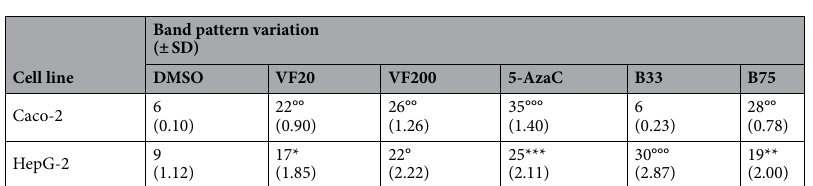
Table 1. Values of band pattern variation obtained by MeSAP analysis (± Standard Deviation of two independent experiments) and densitometer scanning of fingerprinting of mono-digested DNA (MDD) in comparison with double-digested DNA (DDD) expressing the demethylation of both treated cell lines DNA at genome level. (*) 0.05 < p < 0.025; (**) 0.025 < p < 0.02; (***) 0.01 < p < 0.005; (°) 0.005 < p < 0.001; (°°) p < 0.001; (°°°) p < < 0.001, calculated with the χ 2 test in comparison with respective DMSO- treated cells value.